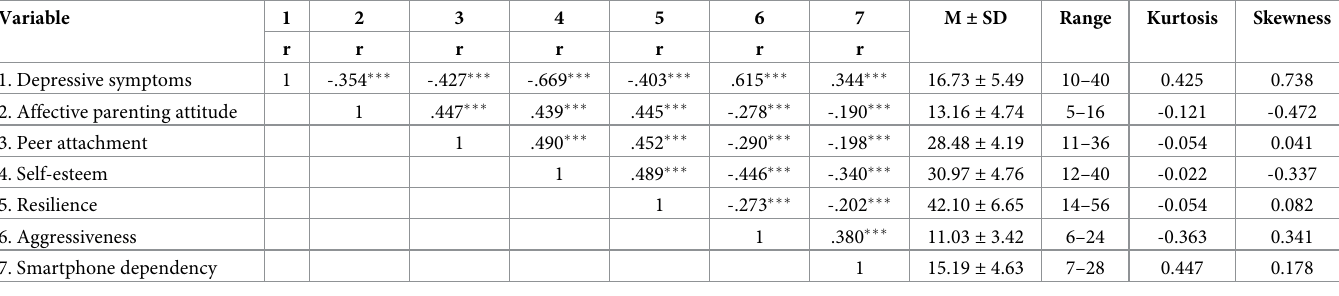
Table 2. Correlation coefficients, means, and standard deviations of the study variables (N = 1840).